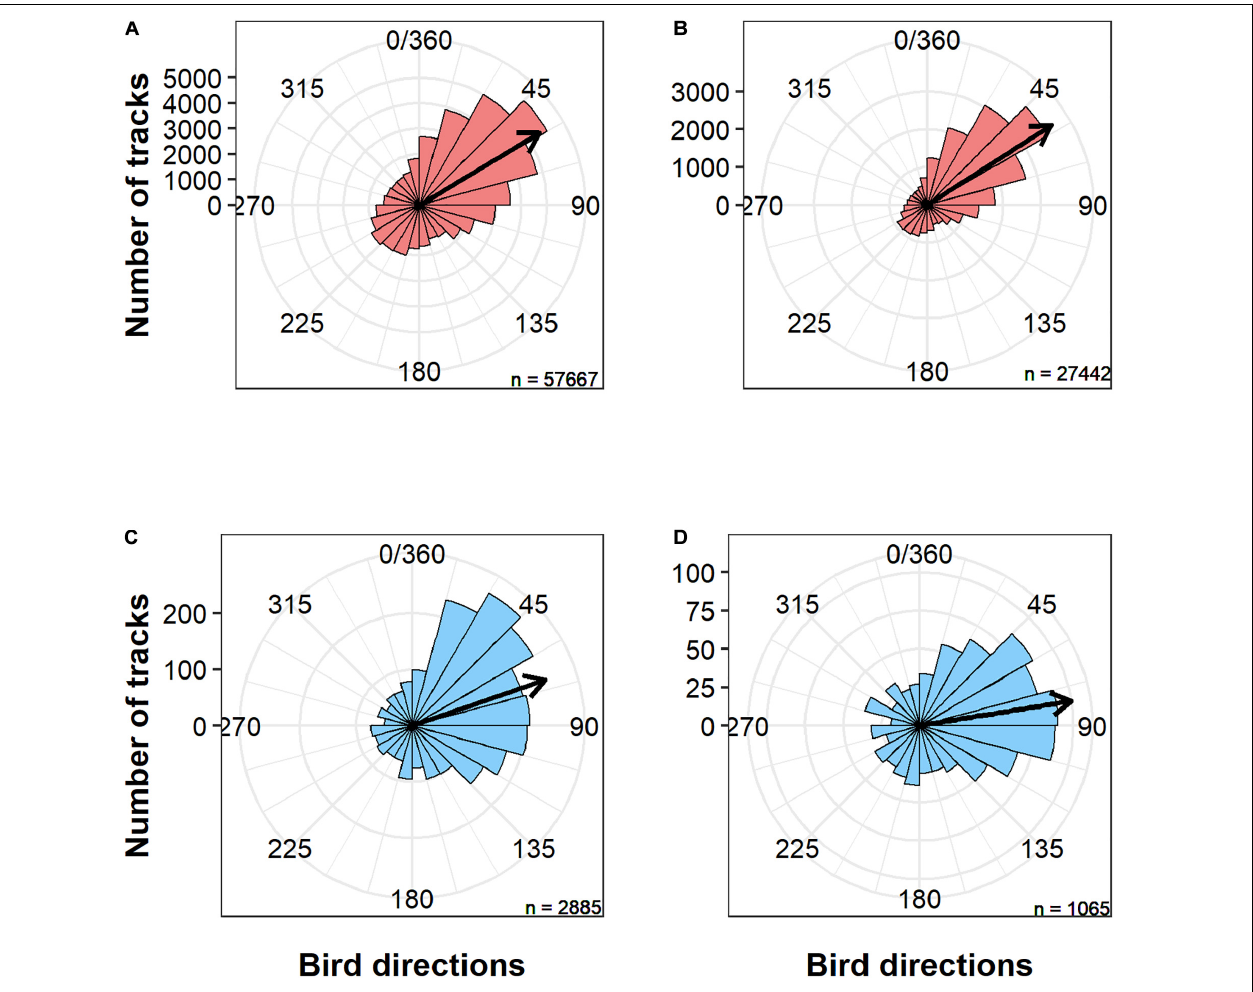
FIGURE 2 | Circular distribution of (A) all tracks recorded under clear skies, (B) tracks recorded under clear skies in selected wind conditions that match those recorded during fog events, (C) tracks recorded under fog conditions, and (D) tracks recorded under fog conditions in selected wind conditions. Black arrows are mean circular directions.